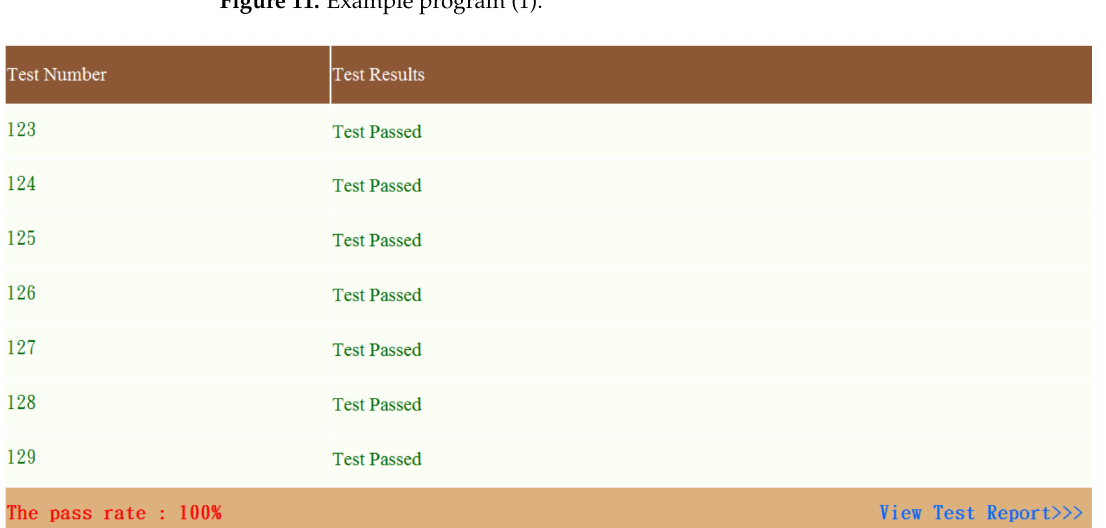
Figure 11. Example program (1).